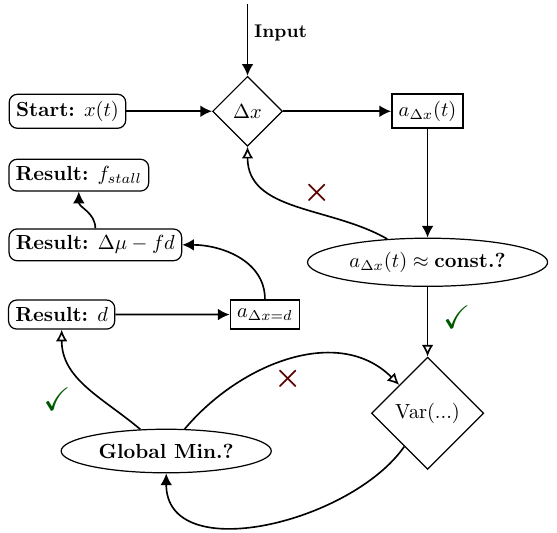
Figure 5. Illustration of the introduced inference procedure. Starting from an observed bead trajectory x ( t ) , we calculate a ∆ x ( t ) for different ∆ x . Around values of ∆ x with approximately constant a ∆ x ( t ) , we identify the minimal value of the variance of a ∆ x ( t ) . The resulting ∆ x corresponds to the motor step width d . For ∆ x = d , the non-time-resolved a ∆ x is equal to ∆ µ